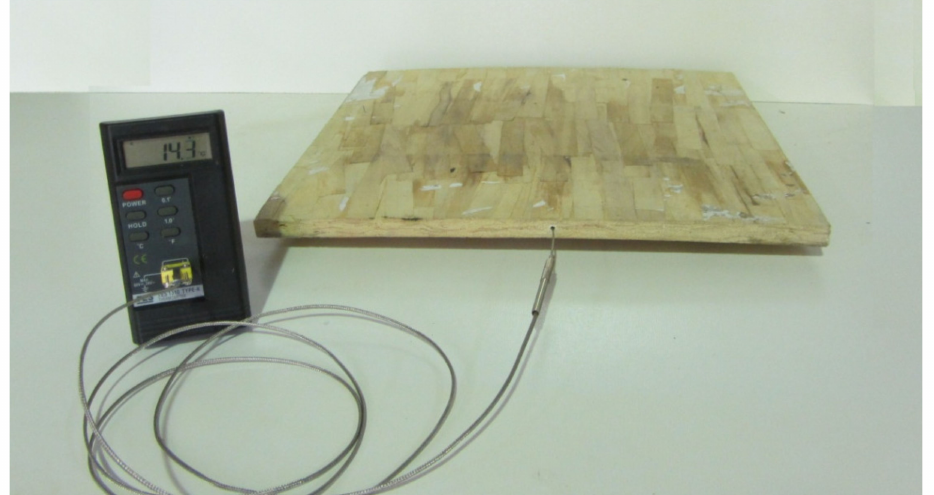
Figure 2. Measurement of temperature at the core of a mat during hot-press using a digital thermometer with 0.1 ◦ C precision; the sensor probe is inserted into the core of the oriented-strand lumber